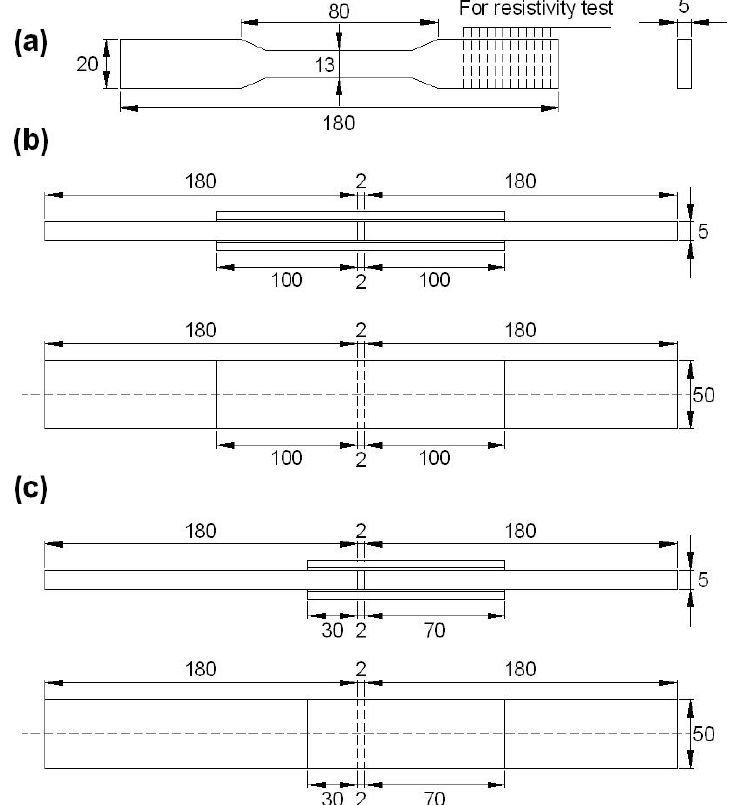
( c ) DJL specimens (unit in mm, not in scale).